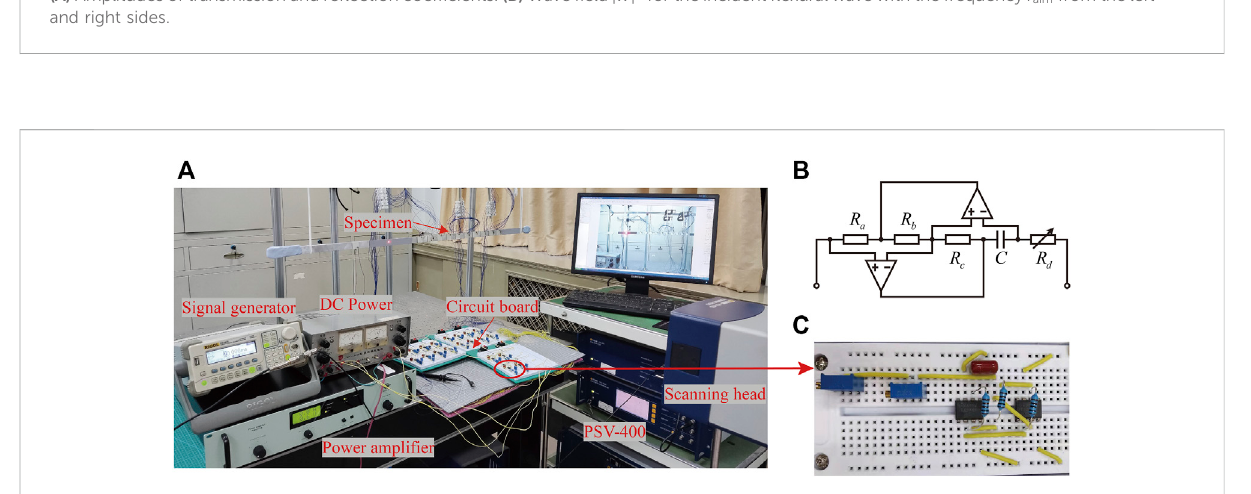
aim from the left